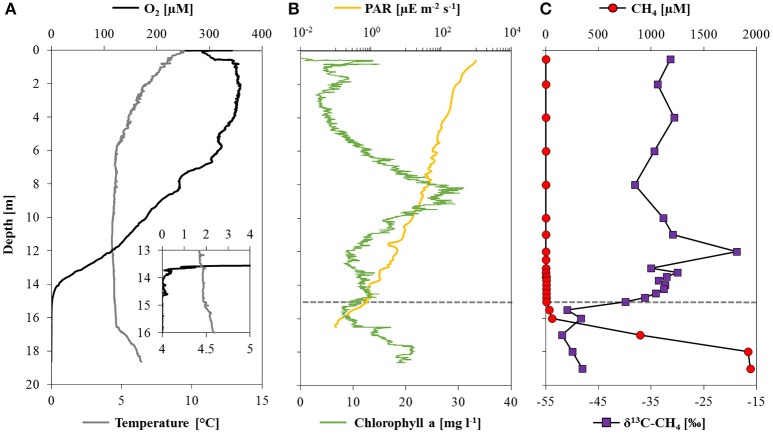
Physicochemical parameters, methane concentrations and stable carbon isotope ratios in Lake La Cruz. (A) Profiles of oxygen and temperature with a detailed view from 13 to 16 m depth, where the oxygen concentration was measured with a trace optode; (B) profiles of photosynthetically active radiation (note the logarithmic scale) and chlorophyll a concentrations; (C) depth profiles of methane concentrations and the corresponding δ13C-CH4. The dashed line denotes the location of the oxycline.